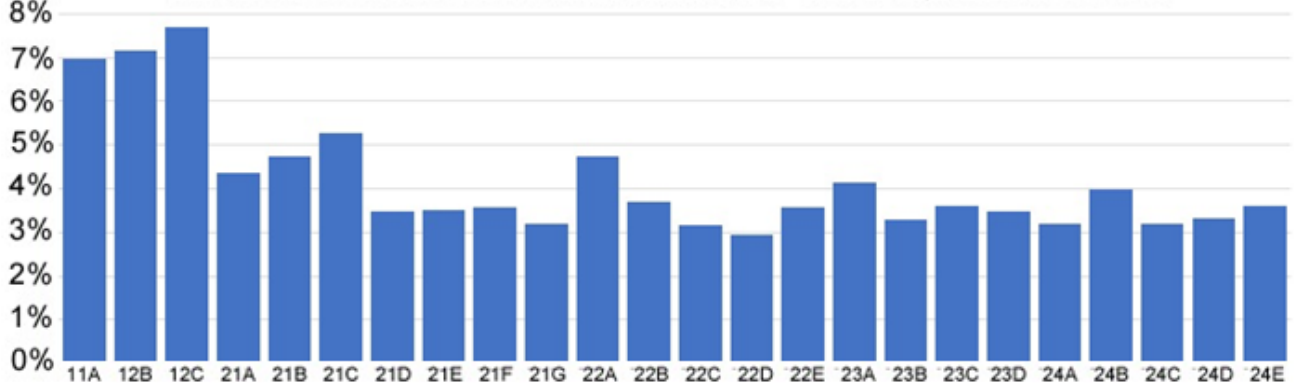
Figure 5. Overall Comparison Matrix of Decision Profile.